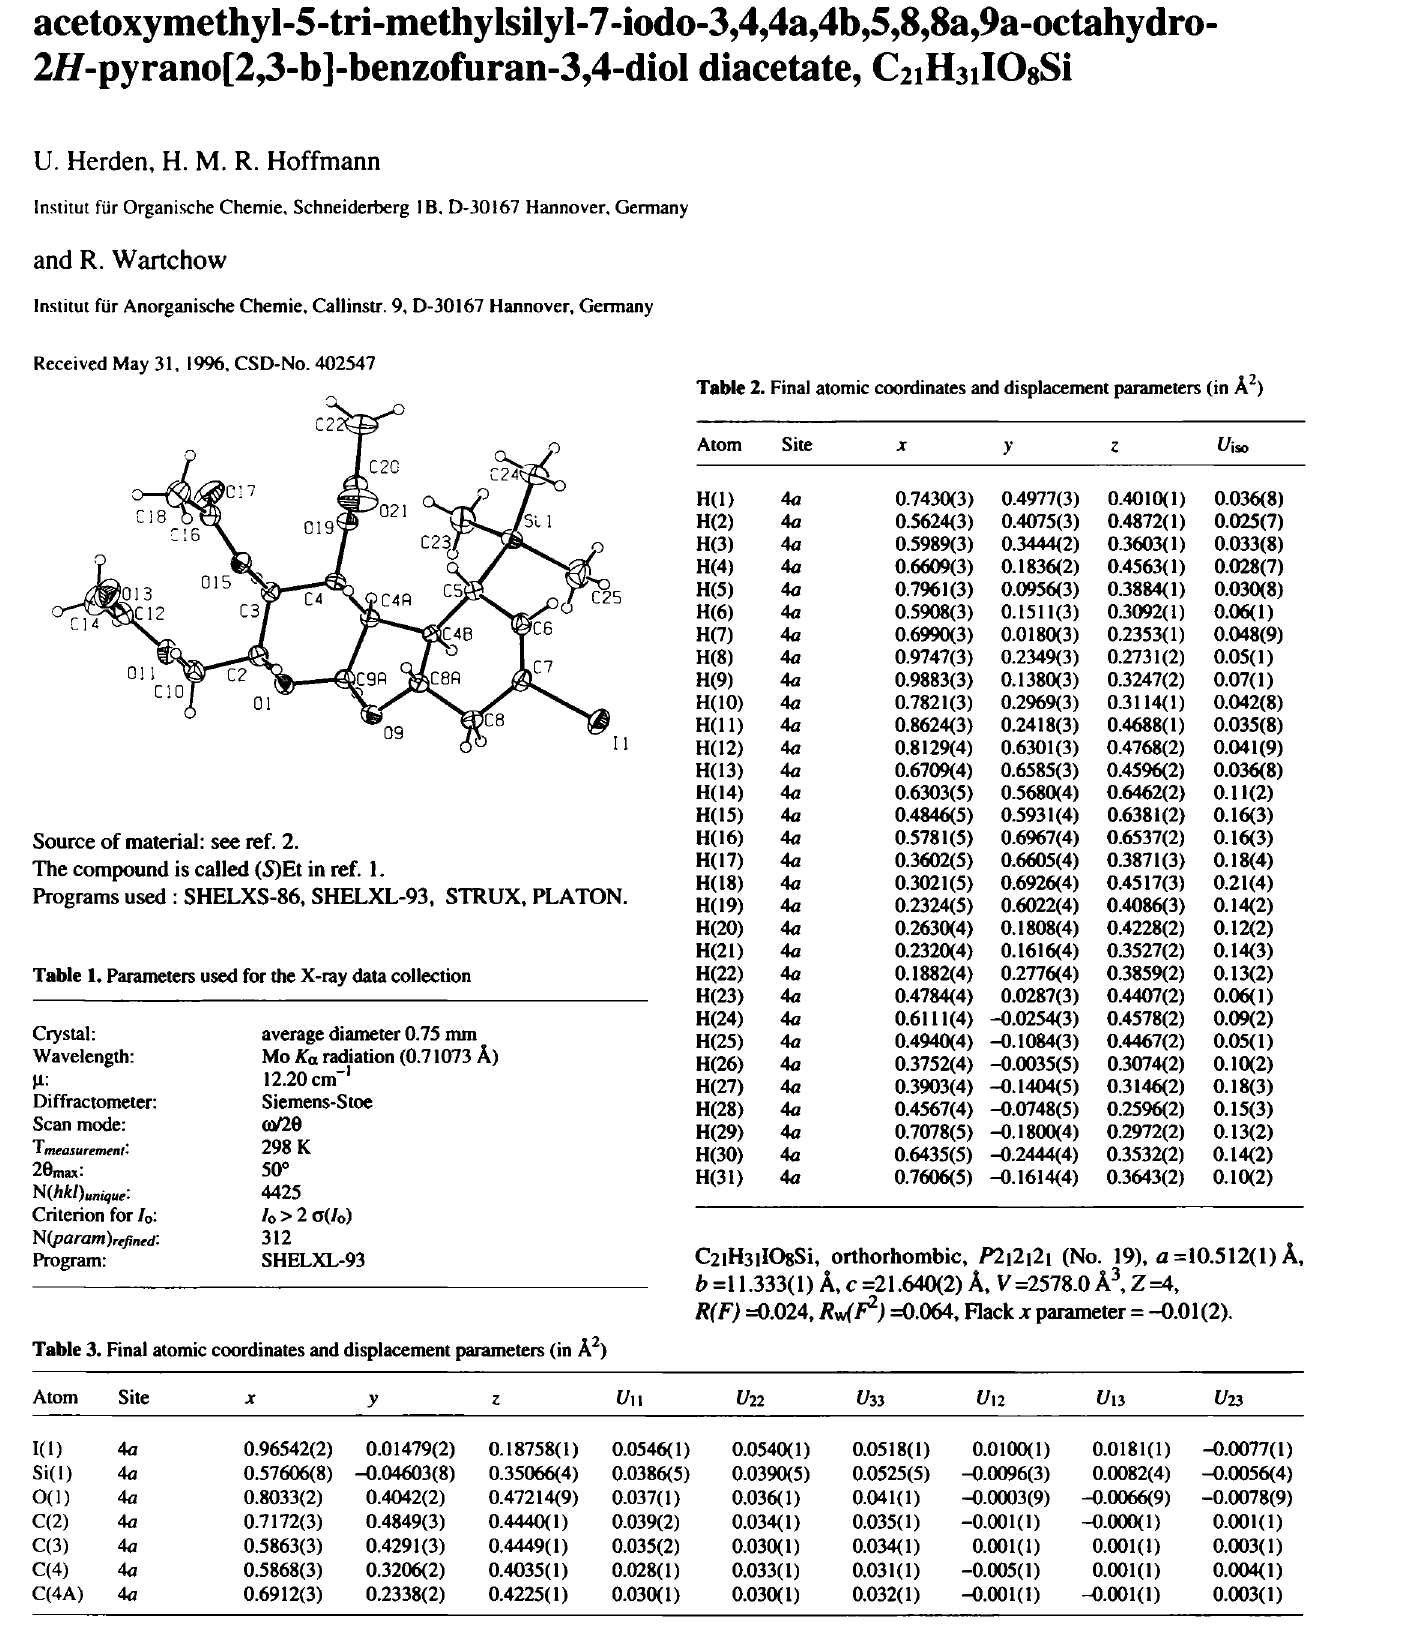
Table 2. Final atomic coordinates and displacement parameters (in Â 2 )